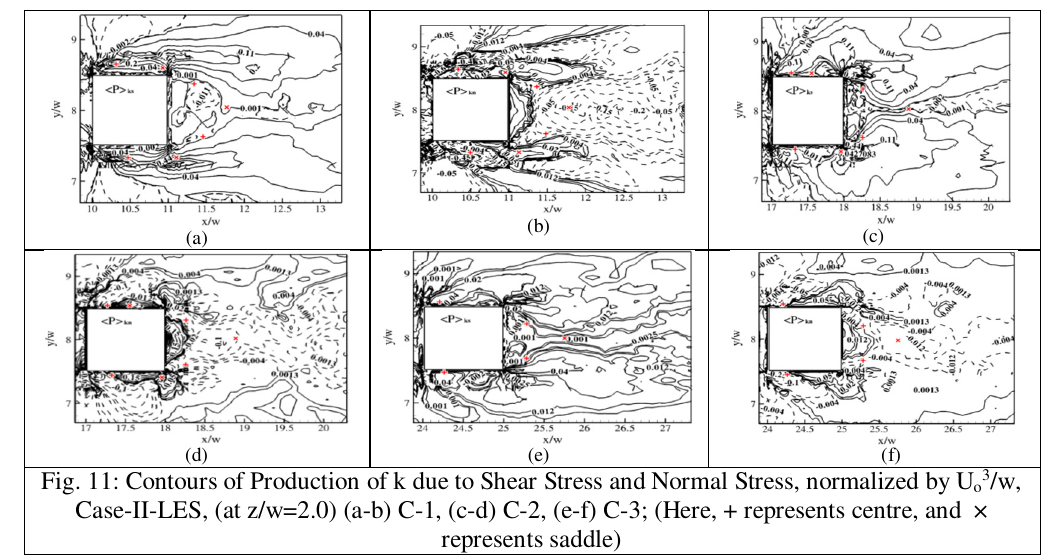
Fig. 11: Contours of Production of k due to Shear Stress and Normal Stress, normalized by U o 3 /w, Case-II-LES, (at z/w=2.0) (a-b) C-1, (c-d) C-2, (e-f) C-3; (Here, + represents centre, and × represents